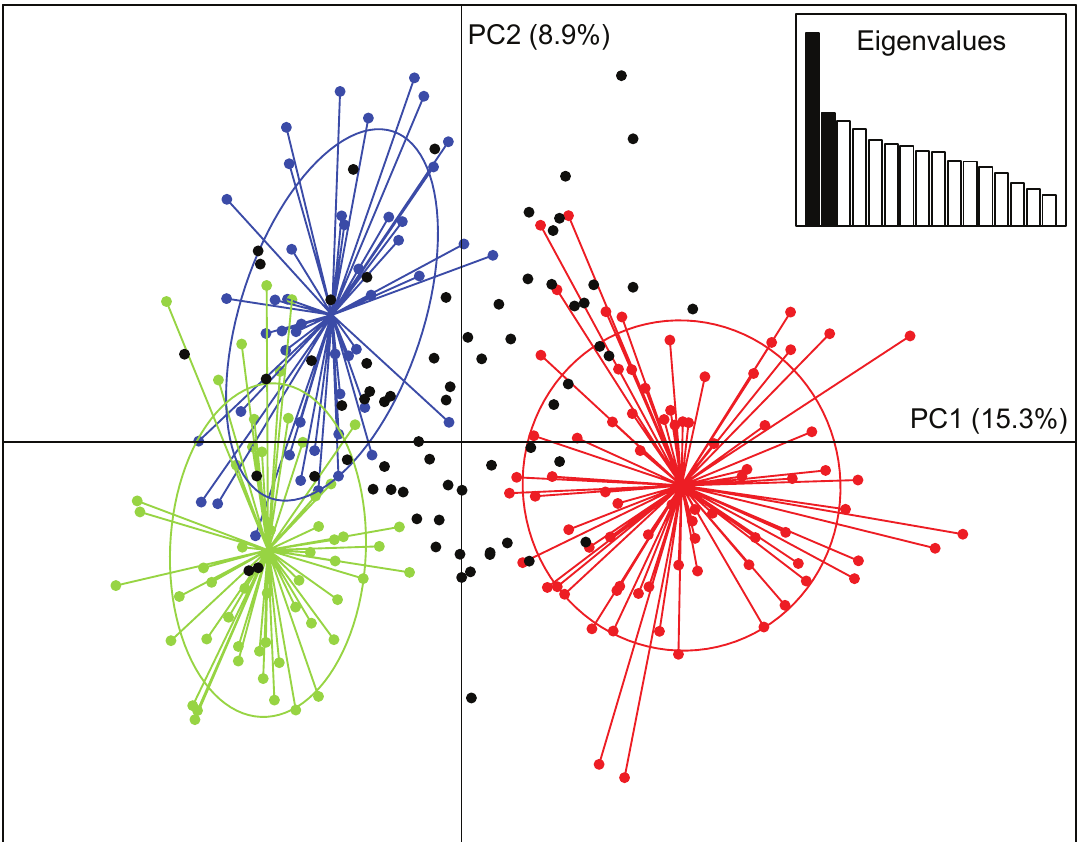
Figure 3. Principal components analysis of 16 autosomal SNPs genotyped in 247 eastern coyotes. Symbol colors correspond to K = 3 STRUCTURE-inferred clusters with > 80% assignment, or black if highly admixed ( i.e. , no assignment > 80%), as in Figure 2C. Inset shows scree plot of